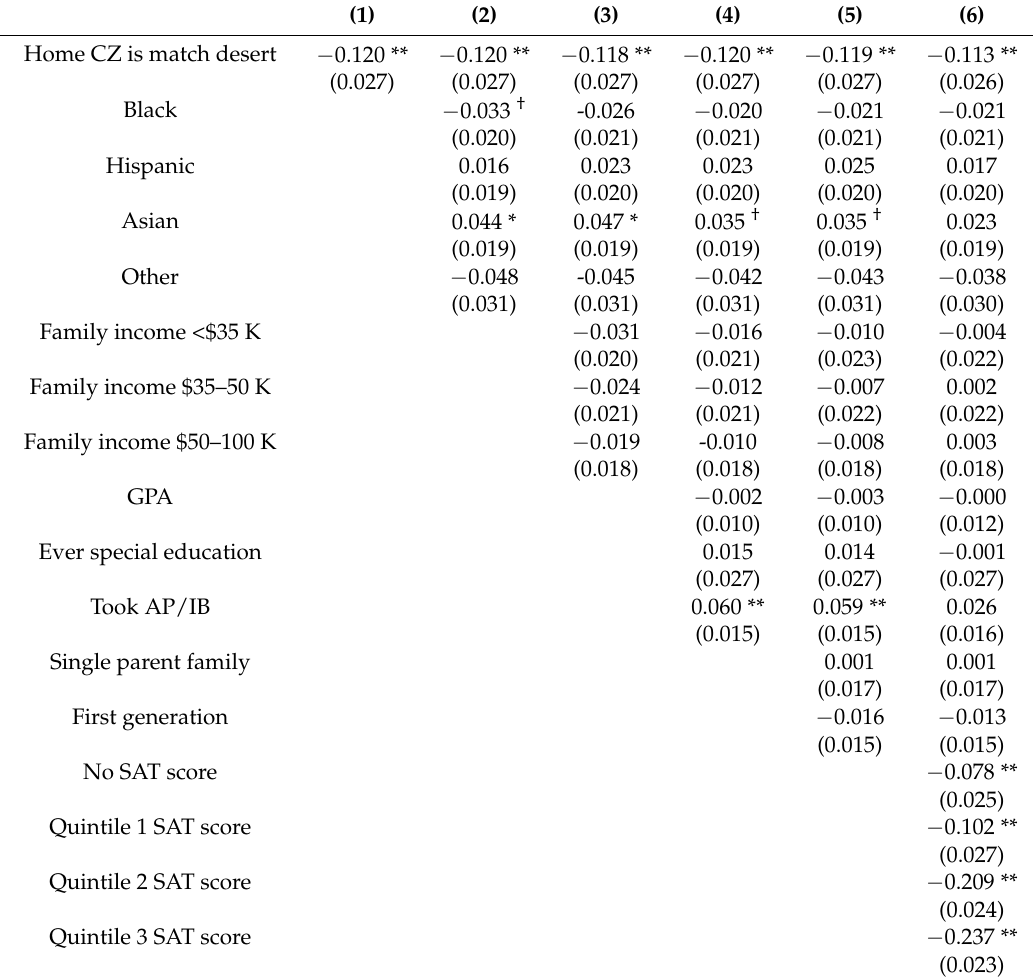
Table A4. Relationship between living in match desert and enrolling an academically-matched